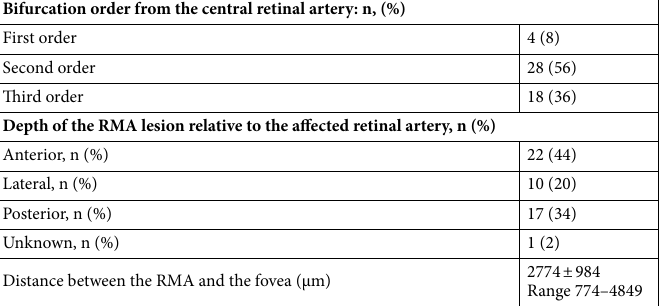
Table 2. Angiographic features of ruptured retinal macroaneurysms. RMA = retinal arterial macroaneurysm.